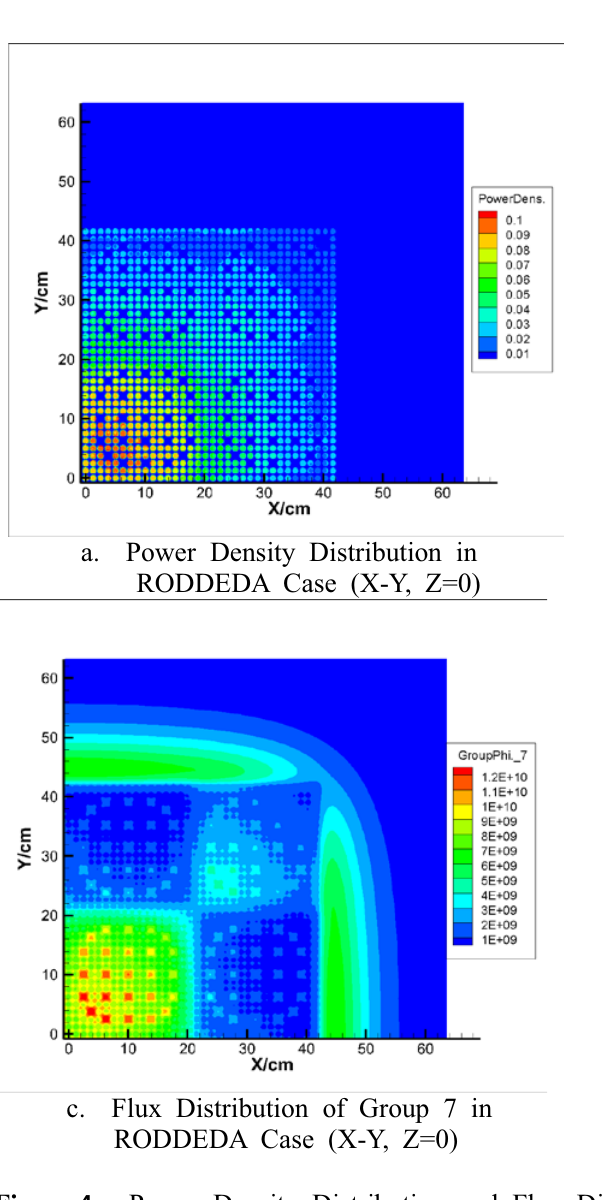
Power Density Distribution and Flux Distribution of Group 7 Form X-Y and Y-Z Cro ss-Section in RODEDDA